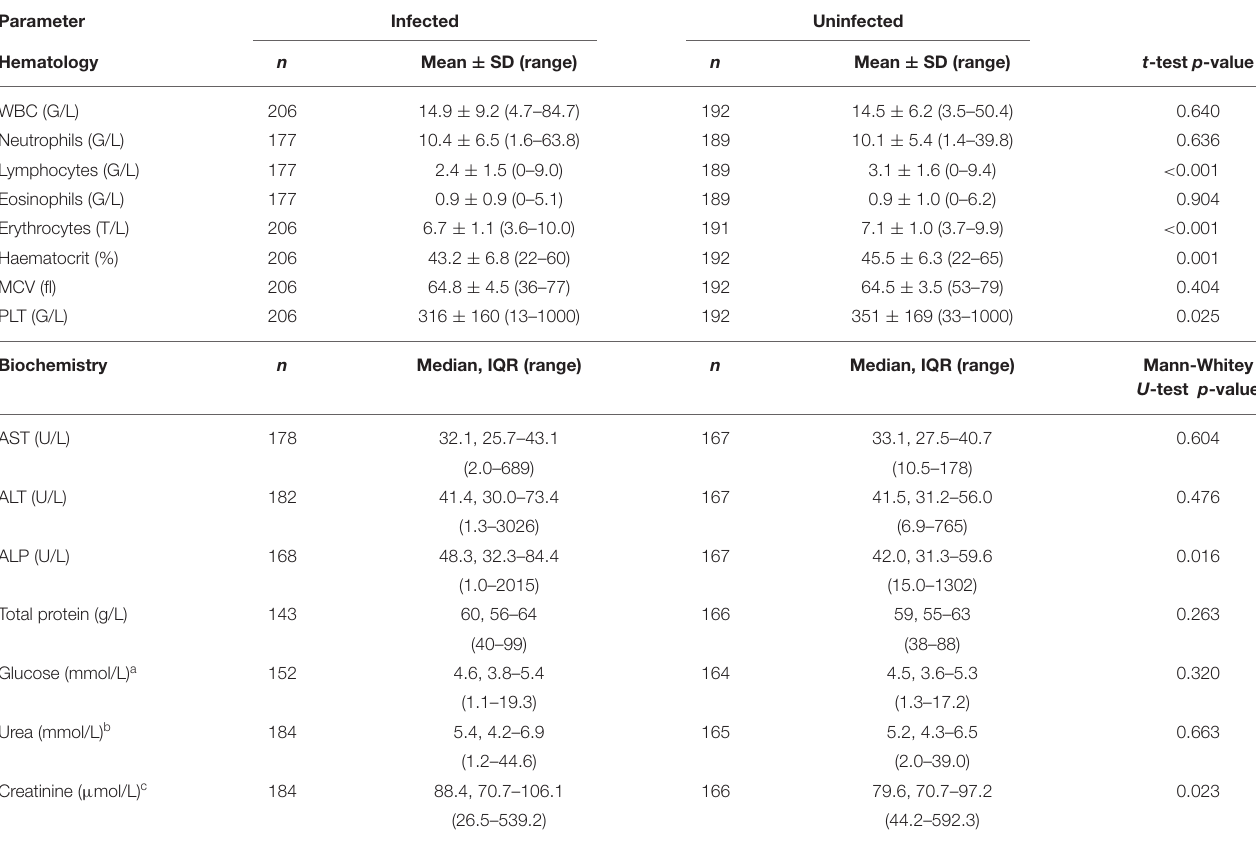
TABLE 2 | Hematological and biochemical parameters in the total study population. Parameter Infected Uninfected Hematology